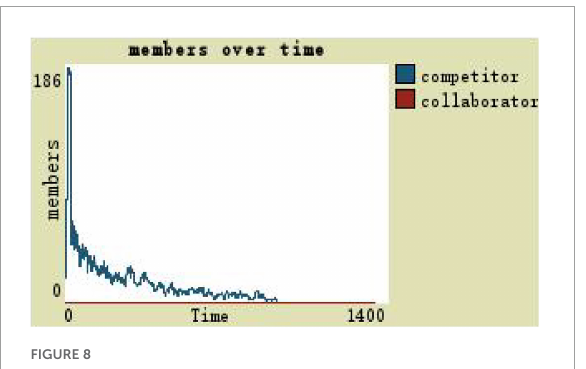
FIGURE8 Members change in low-trust team with the participatory leadership.